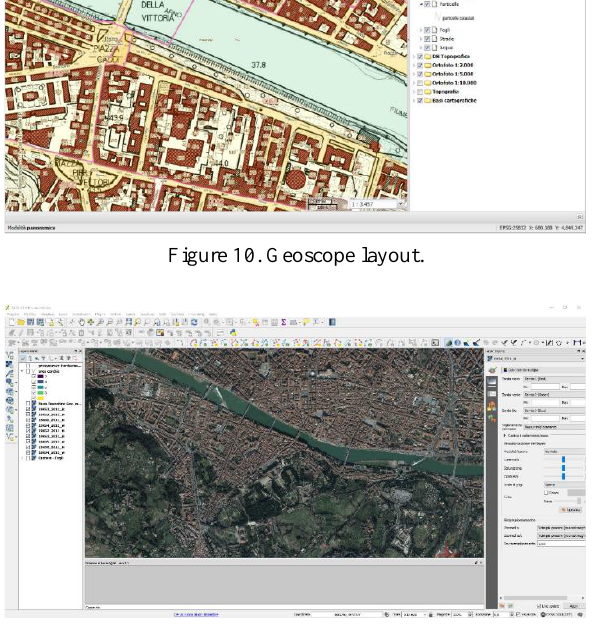
Figure 11. IGM map base